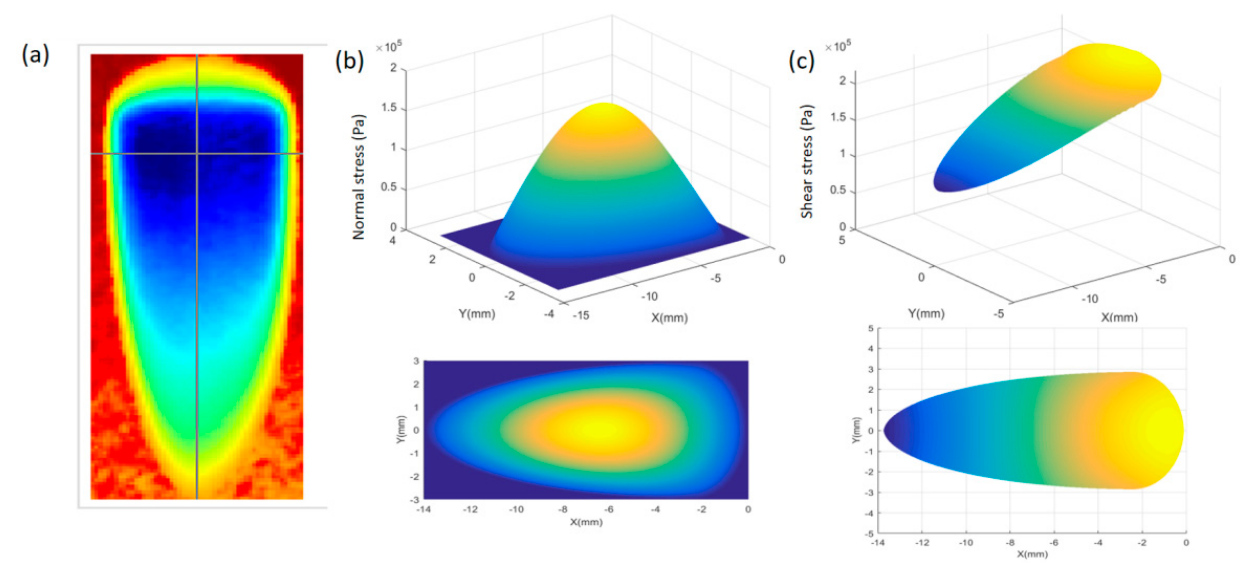
Figure 2. ( a ) MRF polishing spot measured by a ZYGO laser interferometer, ( b ) calculated normal stress distribution, ( c ) calculated shear stress distribution: (top: three-dimensional view of the polishing spot or stress distribution, bottom: view from the z axis of the coordinate system of the workpiece).